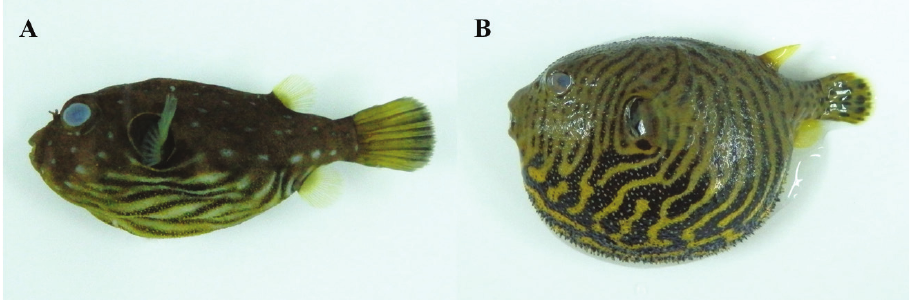
Figure 12. A Arothron hispidus , MFD-807, 36.2 mm SL B Arothron stellatus , MFD-808, 53.1 mm